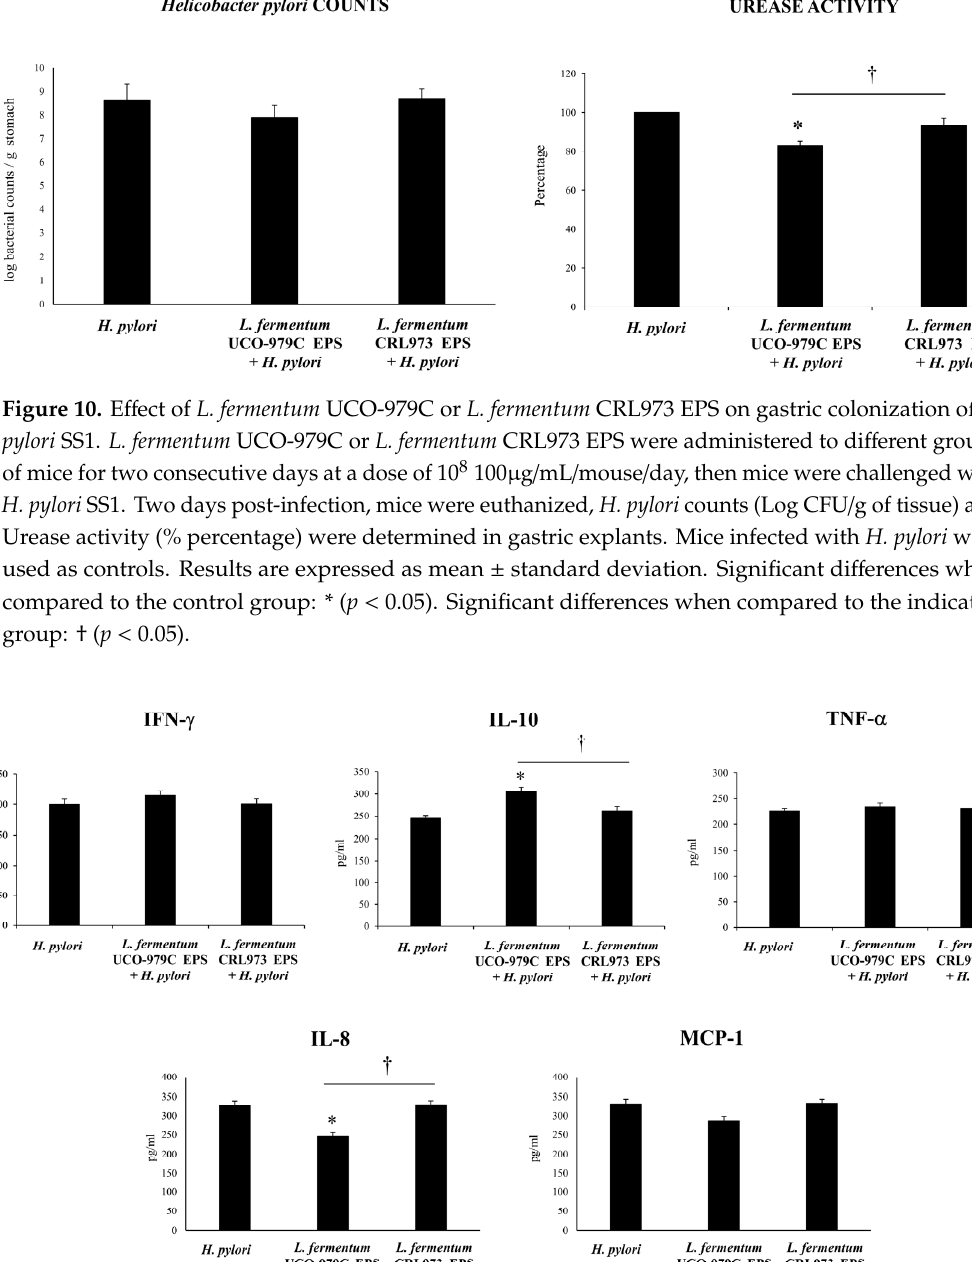
Figure 12. Effect of L. fermentum UCO-979C or L. fermentum CRL973 EPS on serum cytokines and chemokines in adult immunocompetent mice infected with H. pylori SS1. L. fermentum UCO-979C or L. fermentum CRL973 EPS were administered to different groups of mice for two consecutive days at